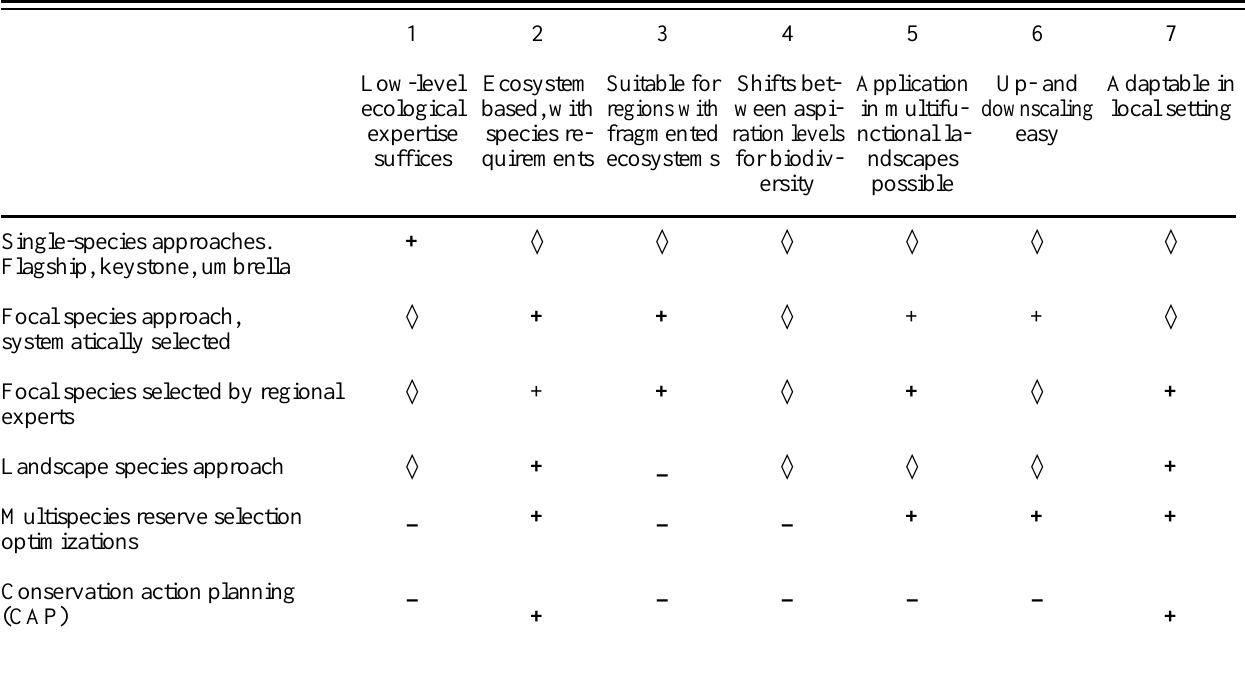
Table 1. Performance of biodiversity goal-setting methods on seven conditions (in columns) for effective use in multifunctional landscape planning.